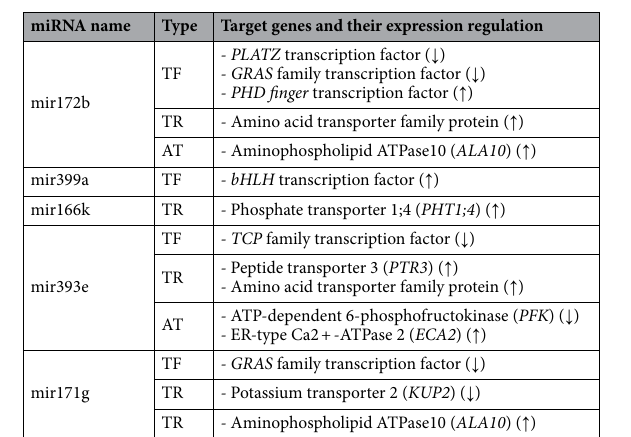
Table 3. Five salt responsive miRNAs in the structural of three selected markers and their predicted salt responsive coding target genes (transcription factor, transporter and ATP binding). TF: Transcription factor, TR: Transporter, AT: ATP binding, ( ↑ ) Upregulation, ( ↓ )